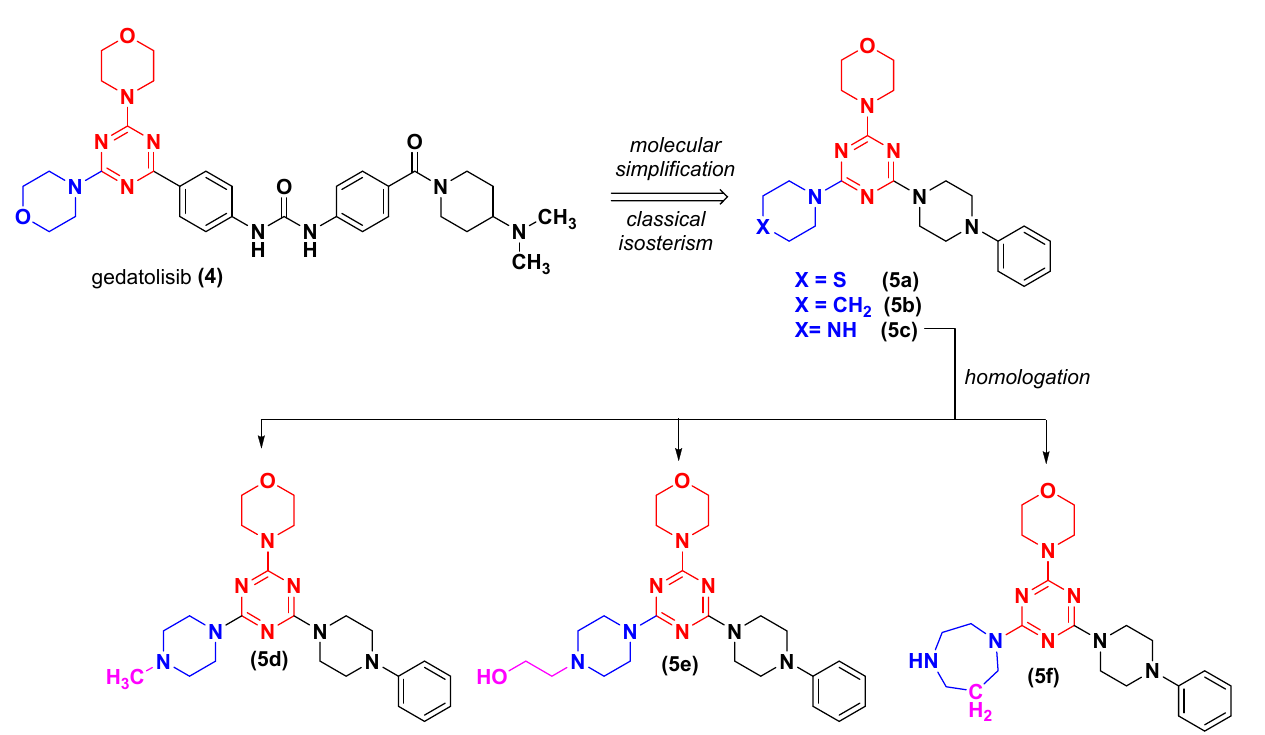
Figure 2. Design concept of compounds 5a-f using gedatolisib as prototype.